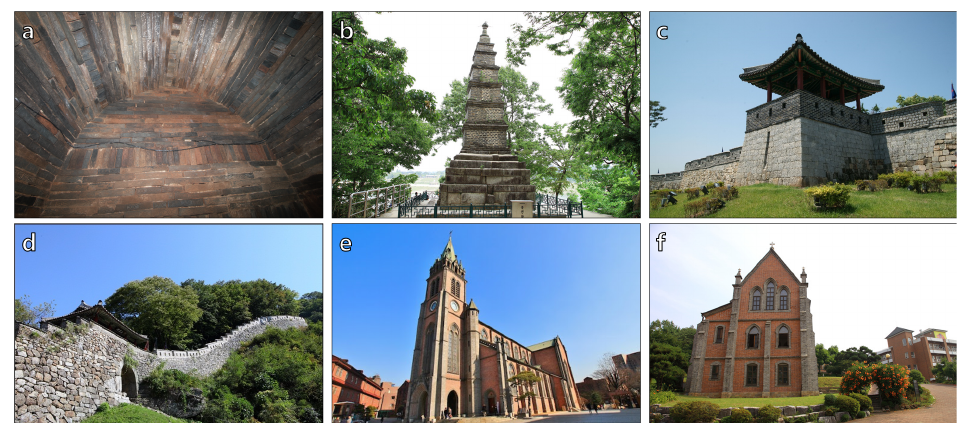
Figure 1. Typical masonry structures in Korea. ( a ) Ancient Tombs in Songsan-ri, Gongju, ( b ) Multi- story Brick Pagoda of Silleuksa Temple, Yeoju, ( c ) Suwon Hwaseong Fortress (listed as a UNESCO cultural heritage site in 1997), ( d ) Namhansanseong Fortress (listed as UNESCO cultural heritage in 2014) ( e ) Myeong-dong Cathedral (Historic Site No. 258), ( f ) Yongsan Seminary, Seoul (Historic Site No.